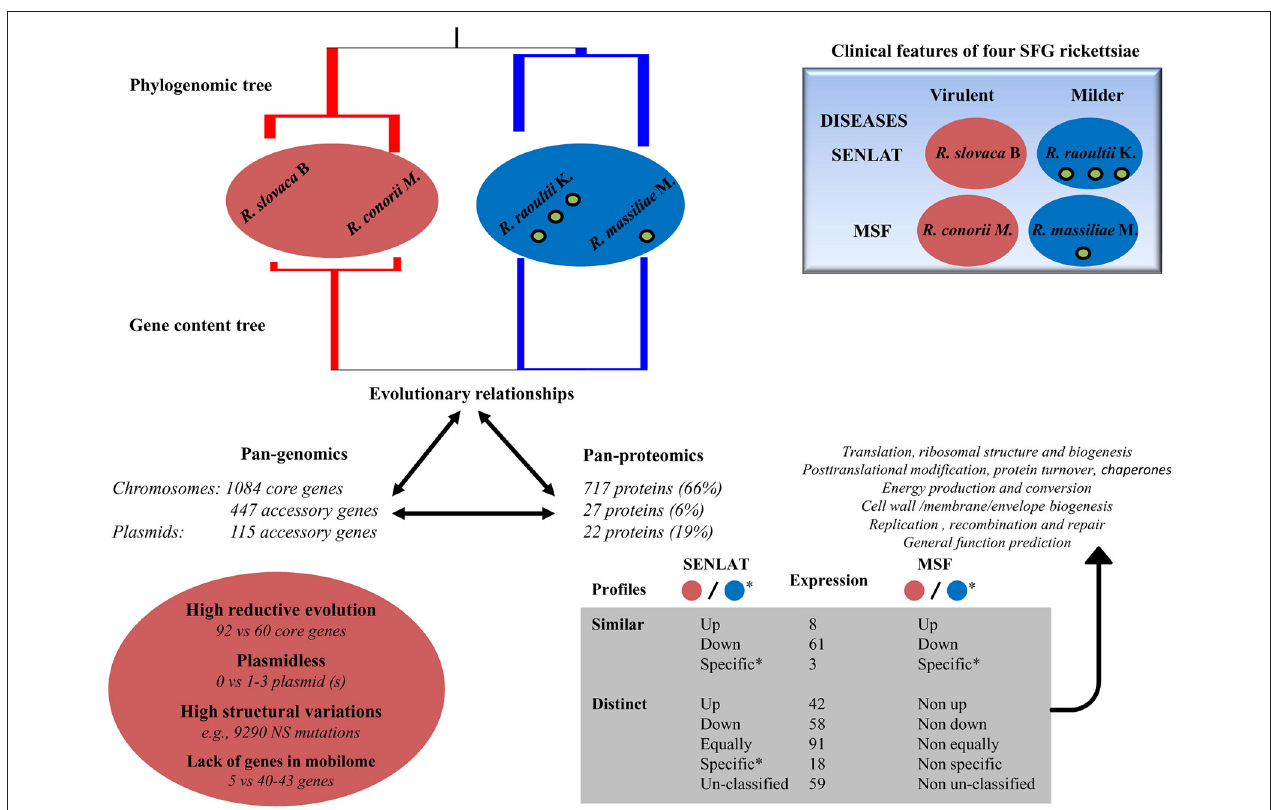
FIGURE 8 | Summary of multi-omics results obtained from comparative analyses between four SFG rickettsiae including the virulent R. slovaca Rsl and the milder R. raoultii Rra which cause SENLAT diseases as well as the virulent R. conorii Rco and the milder R. massiliae Rma which cause MSF diseases. Up, Down, Equally, Specific and Un-classified mean up-regulated, down-regulated, equally regulated, specific and un-classified proteins, respectively. As an example, Non up means that the proteins can be either down-regulated, equally regulated, specific or un-classified proteins. Red and blue colors correspond to the most virulent and the milder agents, respectively. Overall, the two most virulent agents compared with the milder agents exhibited several driving forces that may be associated to differences in virulence and/or plasticity including divergent and reductive evolution, no plasmid, high structural variations and/or a lack of genes in the mobilome. The similarities in the disease (i.e., either SENLAT or MSF) between two distantly related species suggest a convergent evolution. Moreover, the virulent agents also displayed similar and distinct protein profiles mainly in six COG categories. These patterns may include putative virulence- and/or disease-associated proteins as well as putative antivirulence-related proteins of the milder